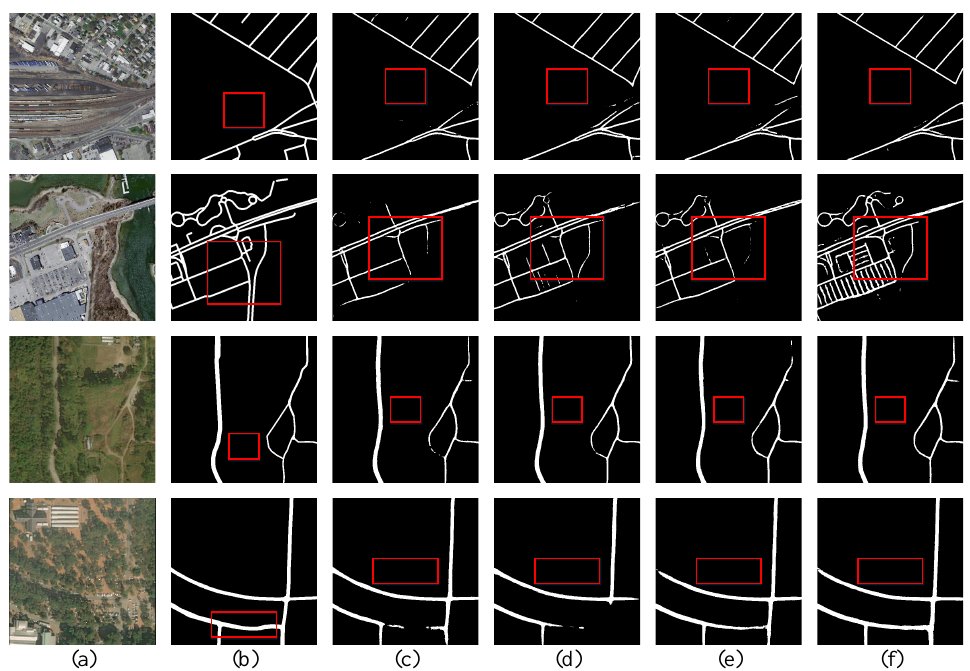
Figure 8. Visualization of the ablation study, where the top two rows are segmentation results for the Massachusetts Roads dataset and the bottom two rows are the segmentation results for the DeepGlobe dataset. ( a ) Original image. ( b ) Ground truth. ( c ) No. 1. ( d ) No. 2. ( e ) No. 3. ( f ) No. 4.